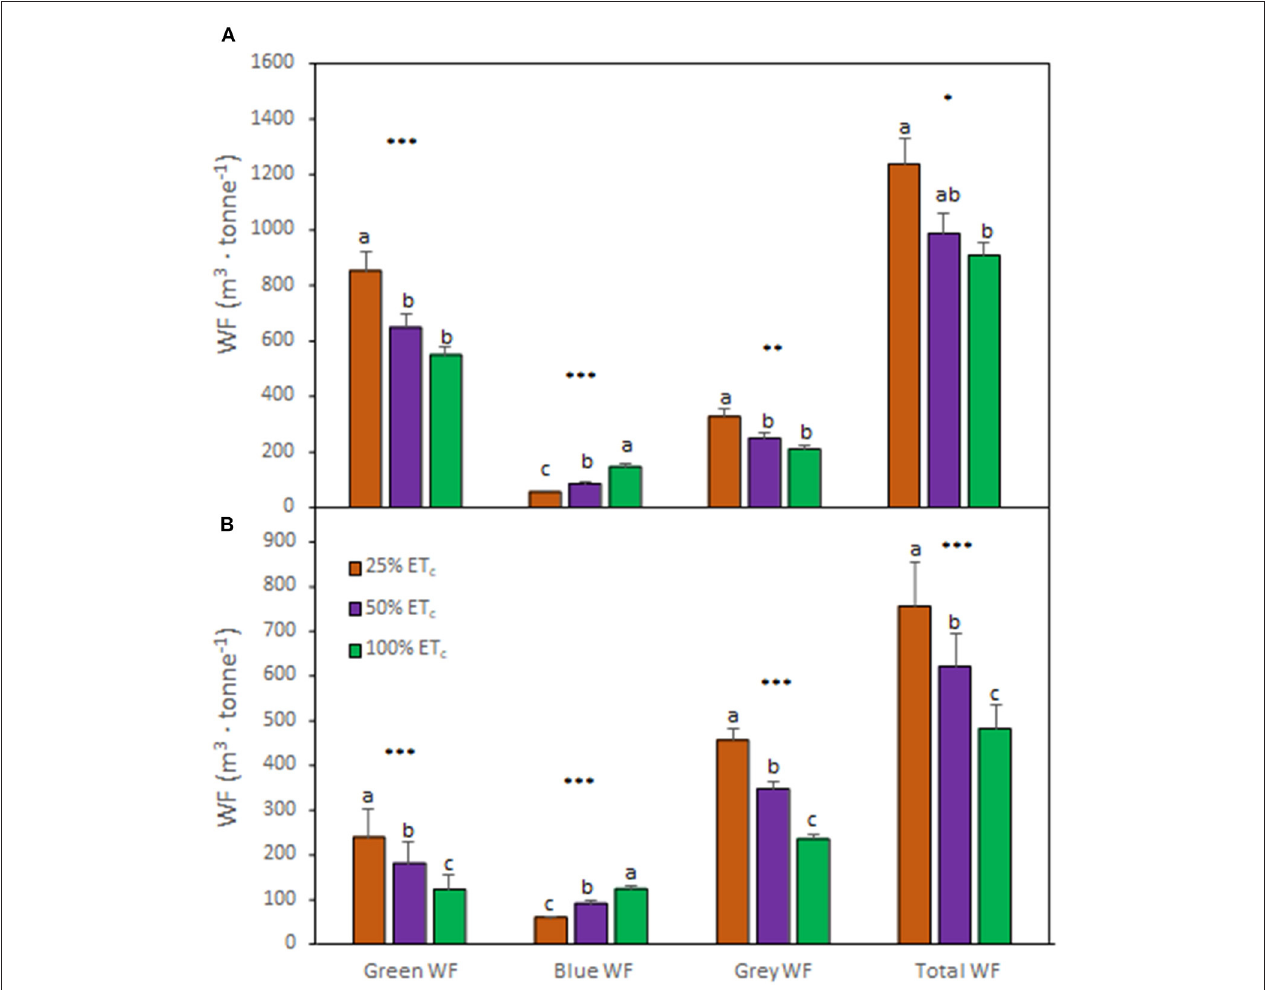
FIGURE 5 | Water footprint (WF) components of Cabernet Sauvignon grapevines (clone FPS08) subjected to different replacement of crop evapotranspiration (25% ET c , 50% ET c , and 100% ET c ), collected in Oakville, CA, in 2018–2019 (A) and 2019–2020 (B) growing seasons. Bars represent means ± SE ( n = 6). At each WF component, different letters indicate significant differences ( p ≤ 0.05) between irrigation treatments according to one-way ANOVA followed by Tukey HSD test. *, **, and *** indicate significance at 5, 1, and 0.1% probability levels,